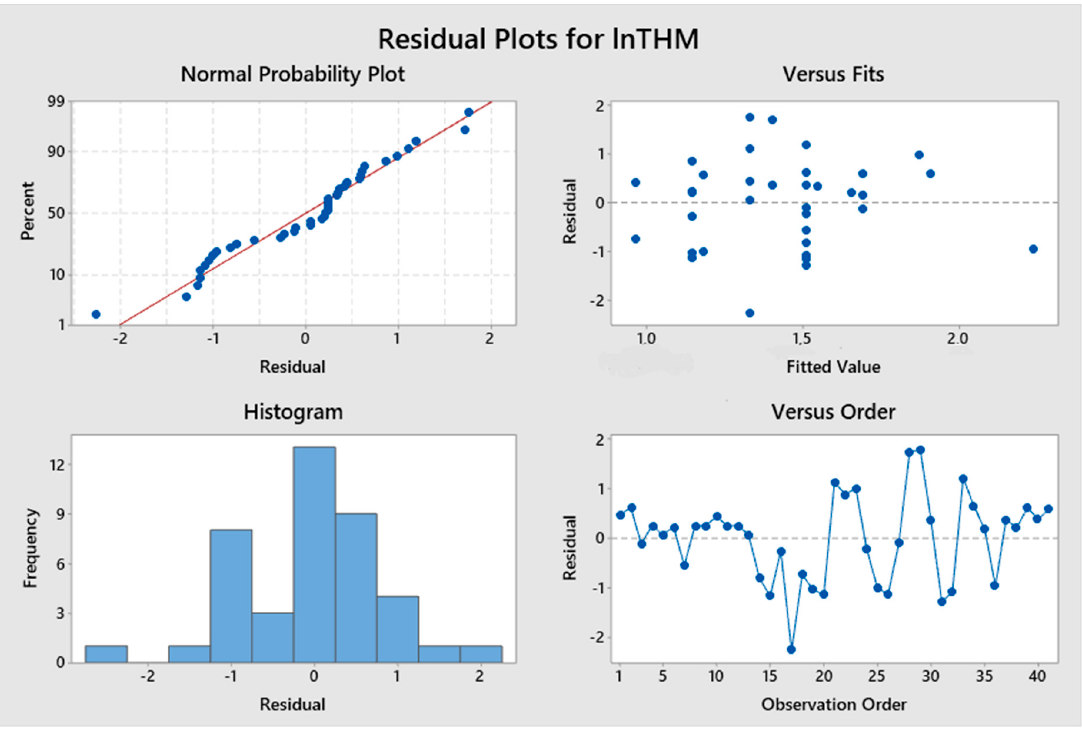
Figure 1. Residual plots for model (2). Water 2020 , 12 , x FOR PEER REVIEW